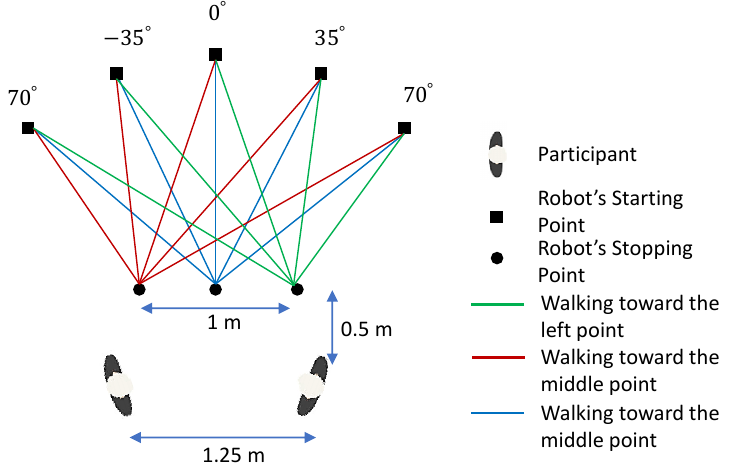
Figure 6. The experimental arrangement of the HRP study reported in